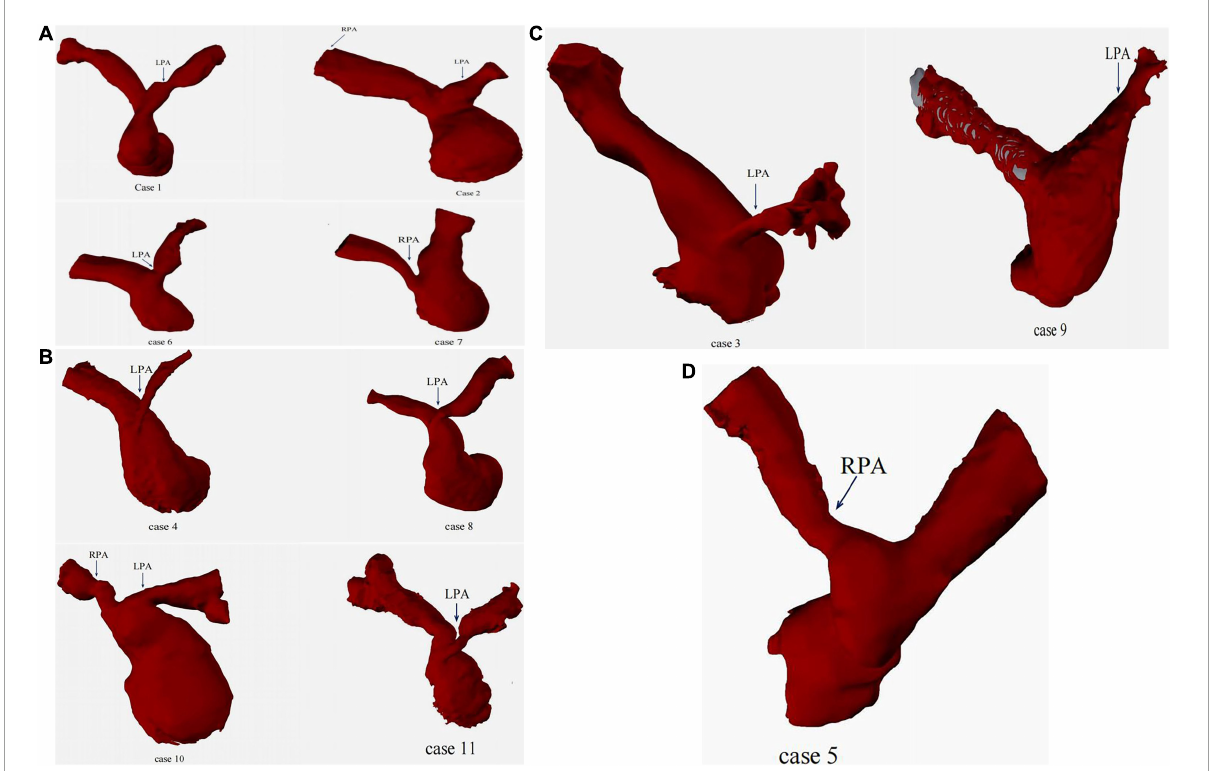
FIGURE4 3D images of branch pulmonary artery. (A) : PA/VSD group; (B) : TOF group; (C) : VSD/PS group; (D) : TGA